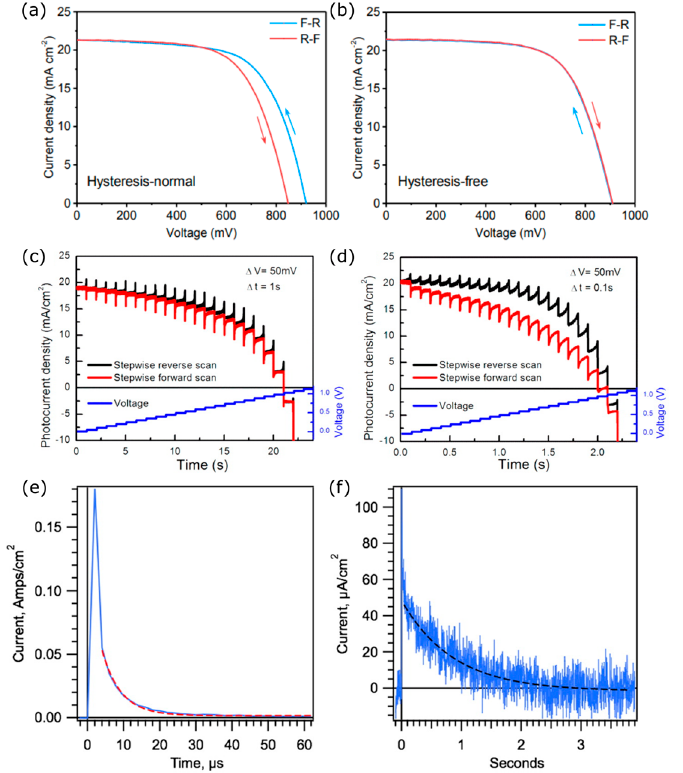
Figure 4. ( a,b ) Current density-voltage curves with forward (R-F) and reverse (F-R) voltage scan direction for a device with hysteresis ( a ) and without ( b ). Reproduced from ref. [66], with permission from The Royal Society of Chemistry, 2017. ( c , d ) Time-dependent photocurrent response under reverse and forward stepped scans with (b) 1 s step time and (c) 0.1 s step time. Reproduced from ref. [67], with permission from American Chemical Society, 2015. ( e , f ) Current decay after removing device from illumination showing two discharging events occurring over different timescales.